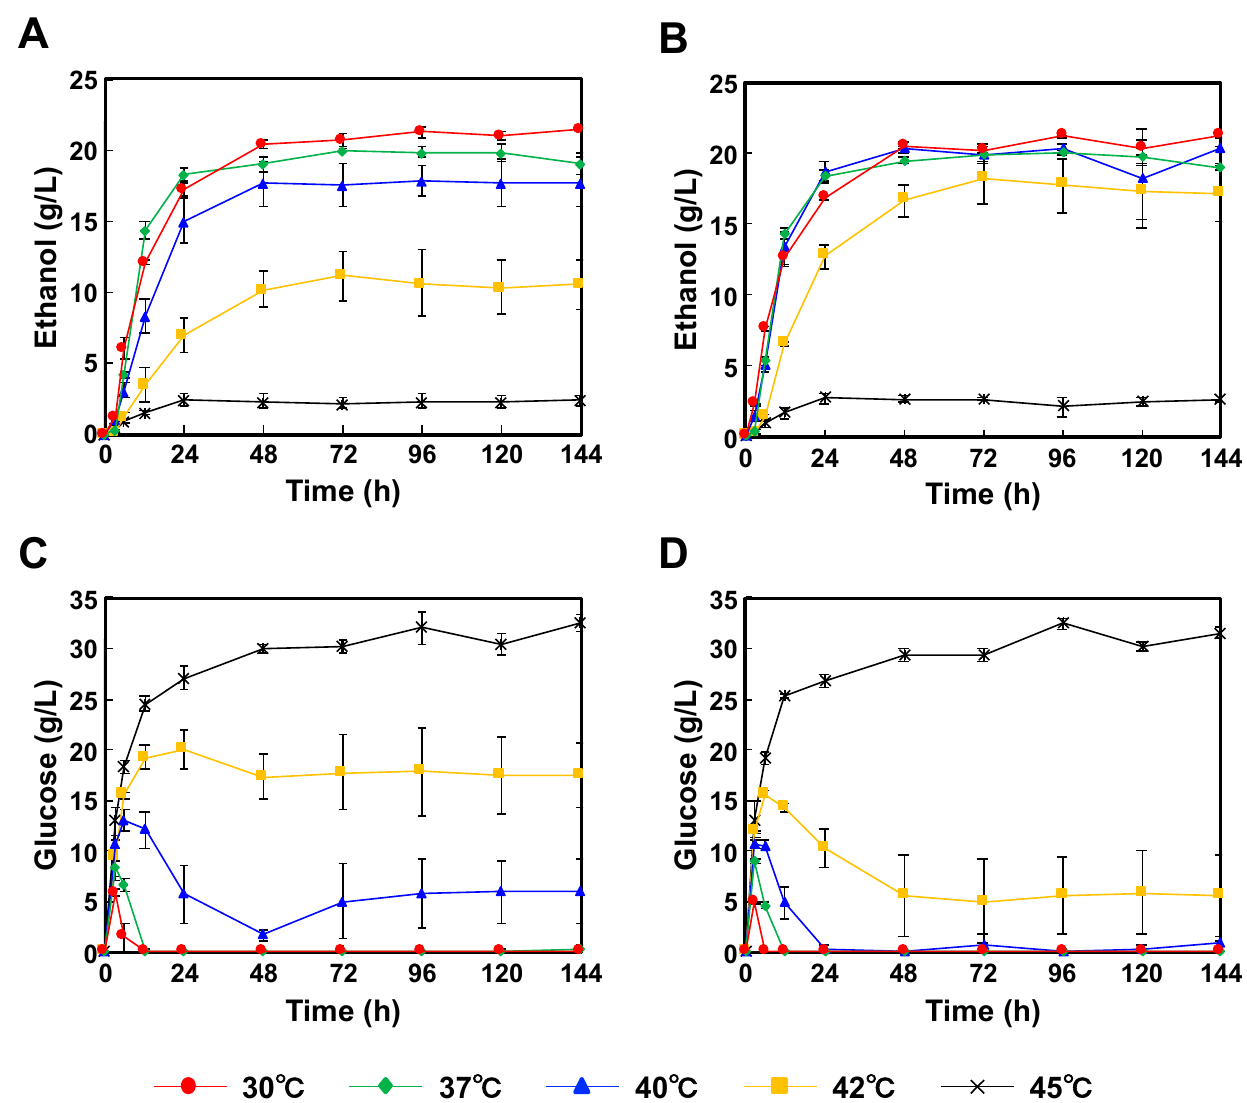
Figure 3. Comparison of the time-courses for P. kudriavzevii NBRC1279 and NBRC1664 during bioethanol production using Japanese eucalyptus particles by SSF. ( A ) Ethanol production with strain NBRC1279; ( B ) Ethanol production with strain NBRC1664; ( C ) Glucose production with strain NBRC1279; ( D ) Glucose production with strain NBRC1664. Error bars indicate SE ( n = 3).